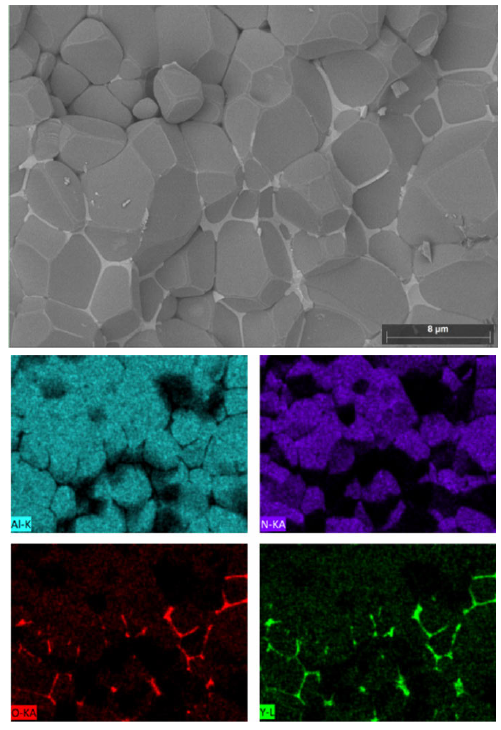
Fig. 8 EDS mapping of the AlN ceramics on fracture